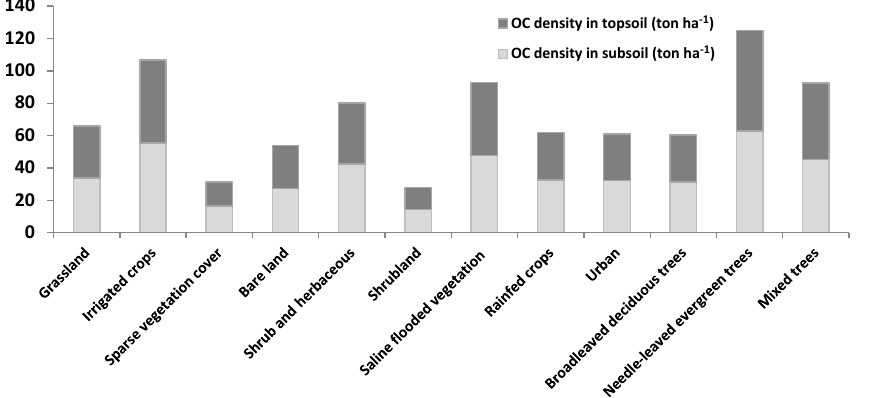
Figure 6. SOC density (tonsha − 1 ) in the topsoil (0–0.3m) and subsoil (0.3–1.0m), calculated from the FAO DSMW (FAO, 2007), with corresponding land cover (http://maps.elie.ucl.ac.be/CCI/viewer/index.php; last access: 10 September 2017).